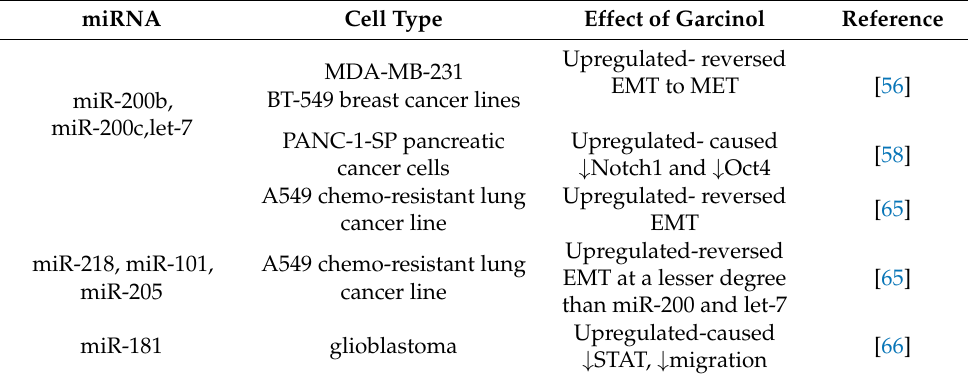
Table 4. Garcinol effects on miRNA in cancer cell